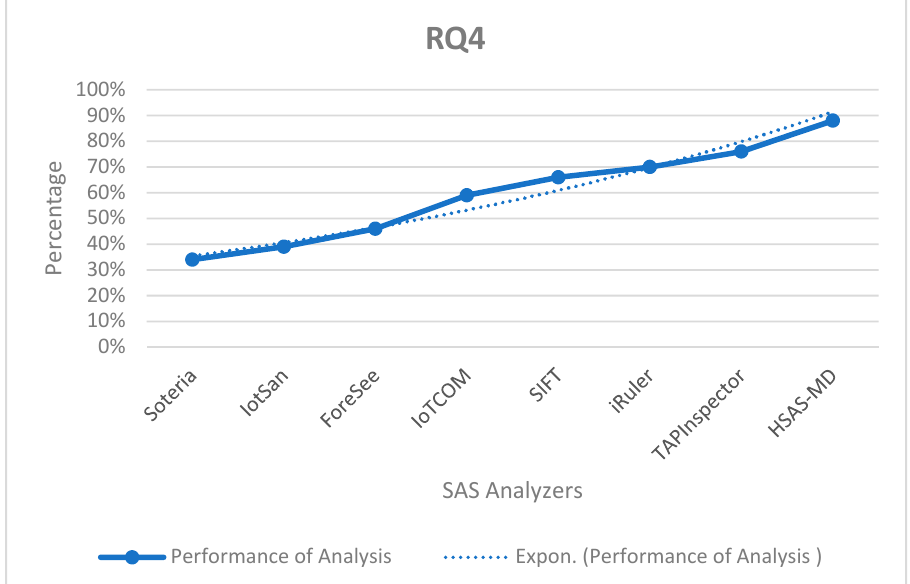
Figure 16. The performance of the proposed HSAS-MD analyzer with other related analyzers based on the static analysis model.